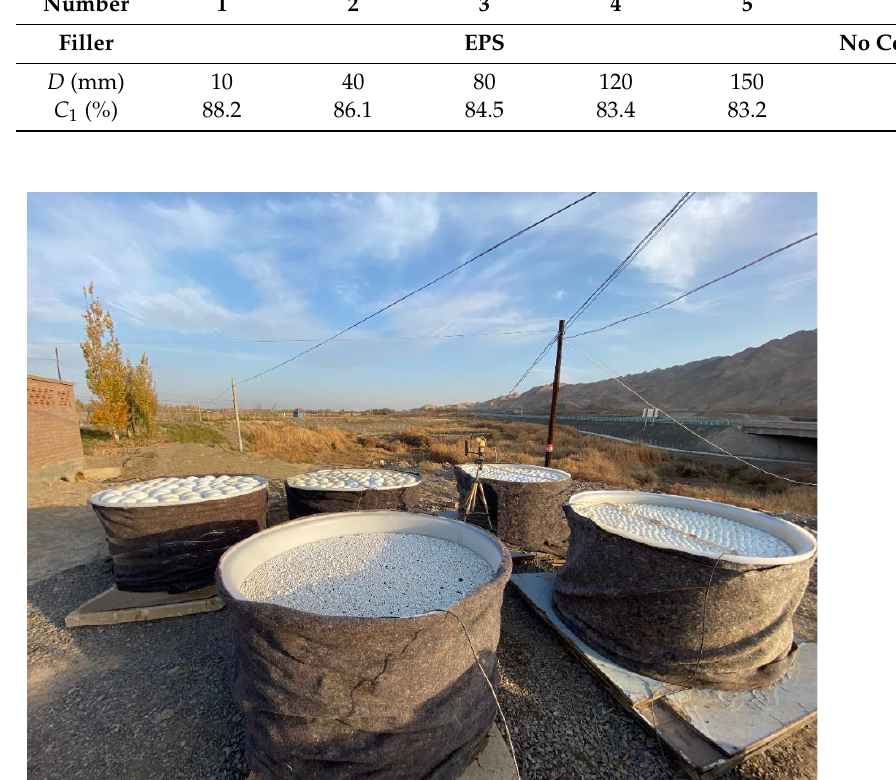
Figure 4. Evaporator test site and setup layout.